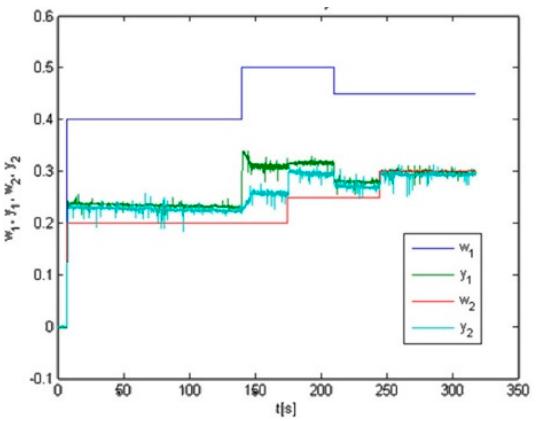
Figure 10. System response (green and cyan) on the given set-points (blue and red).